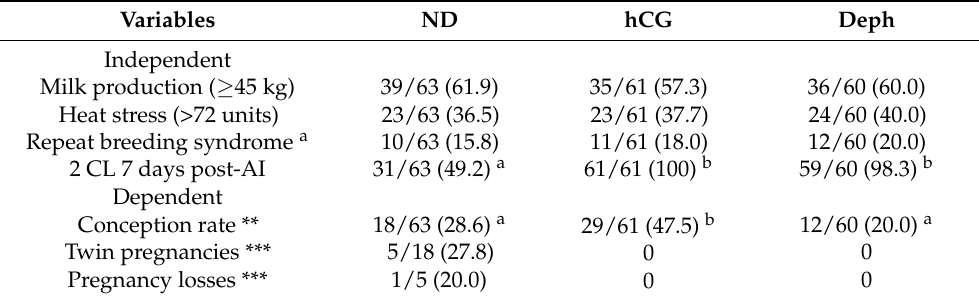
Table 1. Independent variables recorded at the time of treatment and effects of treatment on concep- tion rate, twin pregnancies, and pregnancy